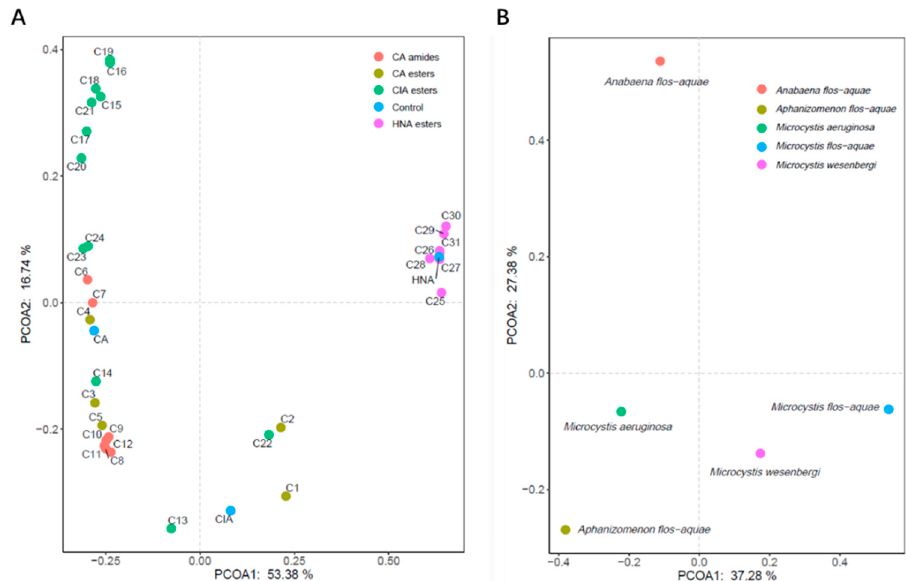
Figure 1. Scatter plots of the first and second principal coordinates of PCoA. ( A ): PCoA analysis based on compounds. ( B ): PCoA analysis based on cyanobacteria.